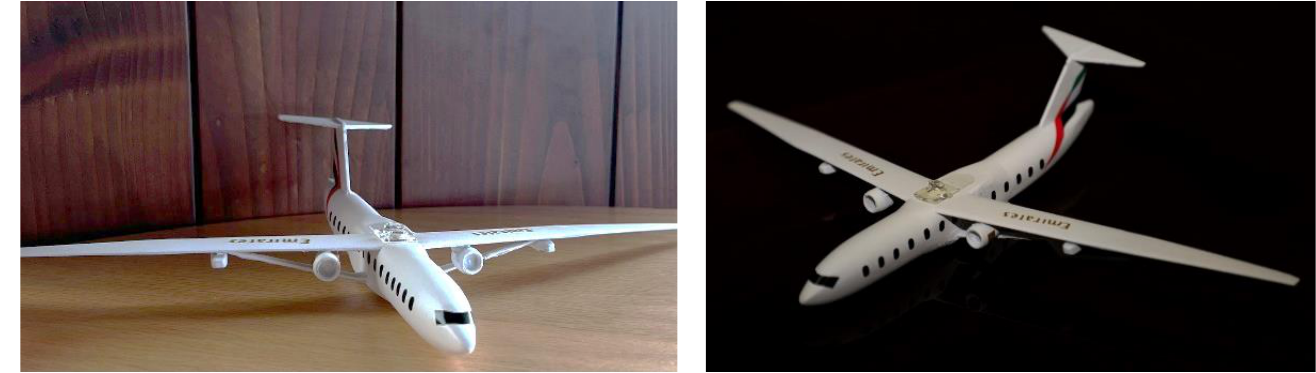
Figure 1. Perspective views of Transonic Truss-Braced Wing (TTBW) 3D printed model.